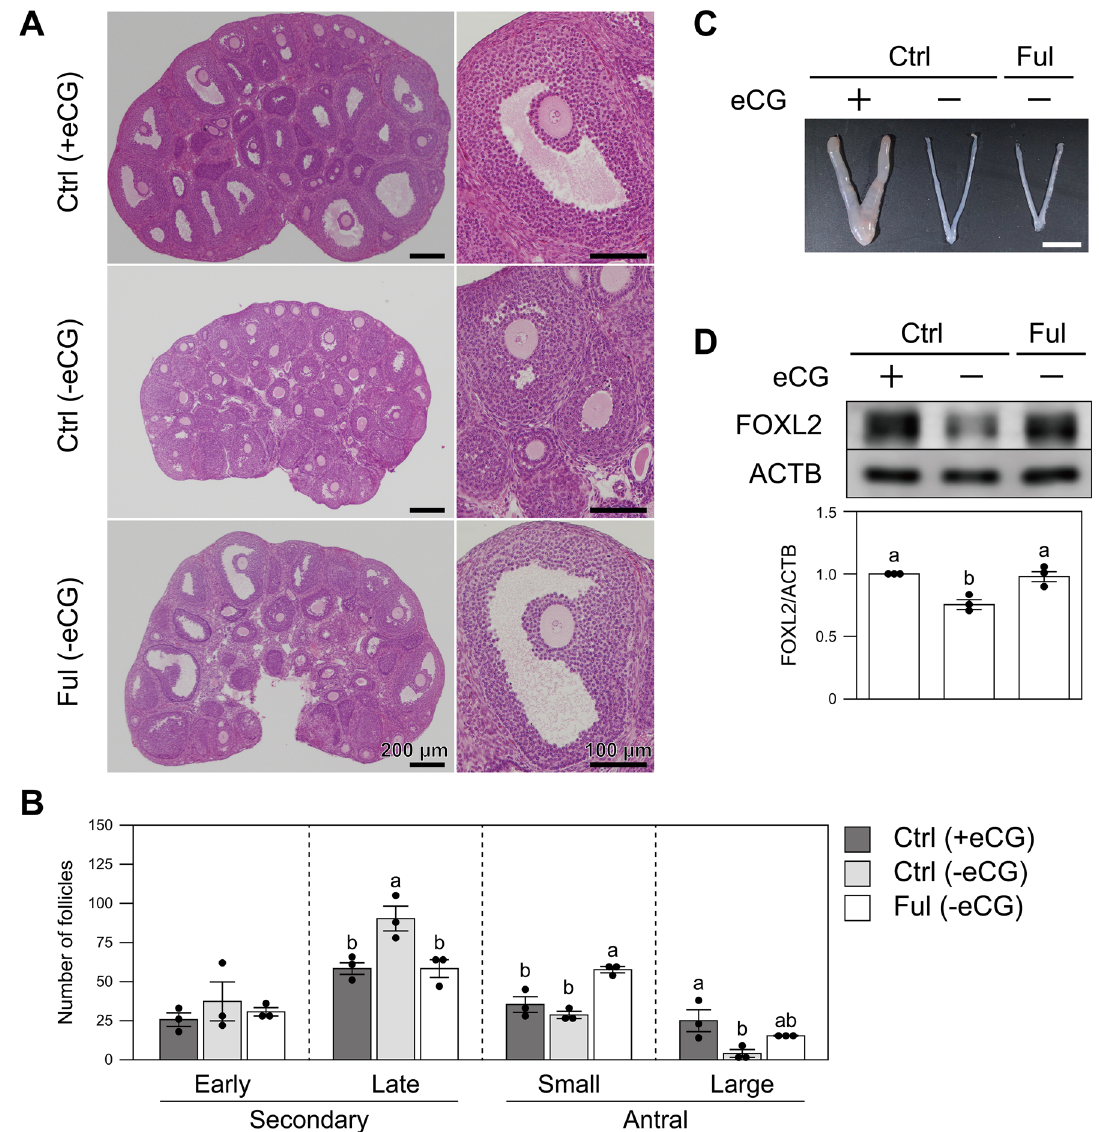
Figure 5. Effects of inhibition of estrogen signaling in vivo . ( A ) Ovaries of fulvestrant (Ful) or vehicle (Ctrl)- injected mice with or without eCG treatment were sectioned and stained with H & E. Scale bar, 200 and 100 μm for left and right panels, respectively. A small or a large antral follicle in each section is shown in the right panels. ( B ) The number of secondary and antral follicles of each ovary was counted (n = 3). ( C ) Morphology of a uterus isolated from a fulvestrant (Ful) or vehicle (Ctrl)-injected mouse. Scale bar, 5 mm. Ctrl (+ eCG), n = 3; Ctrl (-eCG), n = 6; Ful (-eCG), n = 8. ( D ) MGCs were isolated from fulvestrant (Ful) or vehicle (Ctrl)-injected mice and FOXL2 expression was examined by western blotting (upper panel). Band intensities were quantified (lower panel) (n = 3). Different letters (a and b) denote significant differences ( p < previously reported that many transcriptional regulators, such as transcription factors and epigenetic modifiers, are differentially expressed between cumulus cells and MGCs 14 . These differences in expression of transcriptional Conditional deletion of Foxl2 in the adult mouse ovary results in up-regulation of SOX9 in granulosa cells mainly located in the outer portion of early antral follicles, i.e., putative future MGCs, and ultimately the trans- cell phenotype in vivo requires an active mechanism which involves the suppression of SOX9 by FOXL2 13 . Therefore, we expected that the FOXL2-decreased MGCs in our culture system would exhibit elevated SOX9 expression and acquire the characteristics of Sertoli cells. In fact, the level of Sox9 transcripts was significantly increased in MGCs maintained without oocytes or estrogen. However, the Sox9 level was notably lower than that in testicular cells, and SOX9 protein expression was barely observed in the cultured MGCs. While further